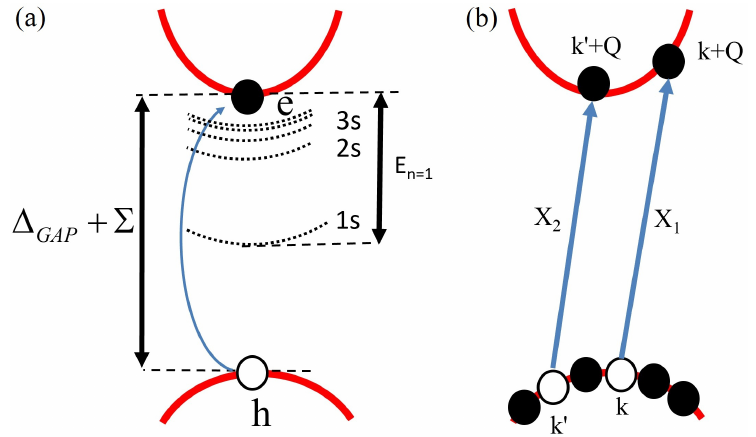
Figure 8. ( a ) The single electron–single hole picture (exciton in effective mass approximation) in which interaction creates a spectrum of bound states. ( b ) Exact picture where the “hole” is created by exciting the electron from the filled ground state in the VB. The exciton is then constructed as a coherent superposition of all possible excitations for a given center-of-mass momentum (cid:126) Q CM interacting via the Coulomb interaction.